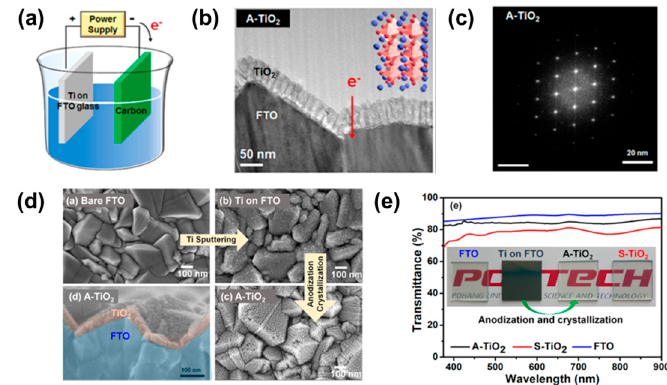
Figure 5. ( a ) Illustration of anodizing process. ( b ) Cross-sectional TEM image of anodized TiO 2 ( c ) electron energy loss spectroscopy (EELS) image of resulting nanostructure. ( d ) Top down and cross-sectional SEM images of nanostructure on FTO substrate. ( e ) Transparent measurement of anodized and spin-coated TiO 2 layer on FTO substrate. Reprint with permission [15]; 2016, American Chemical Society.